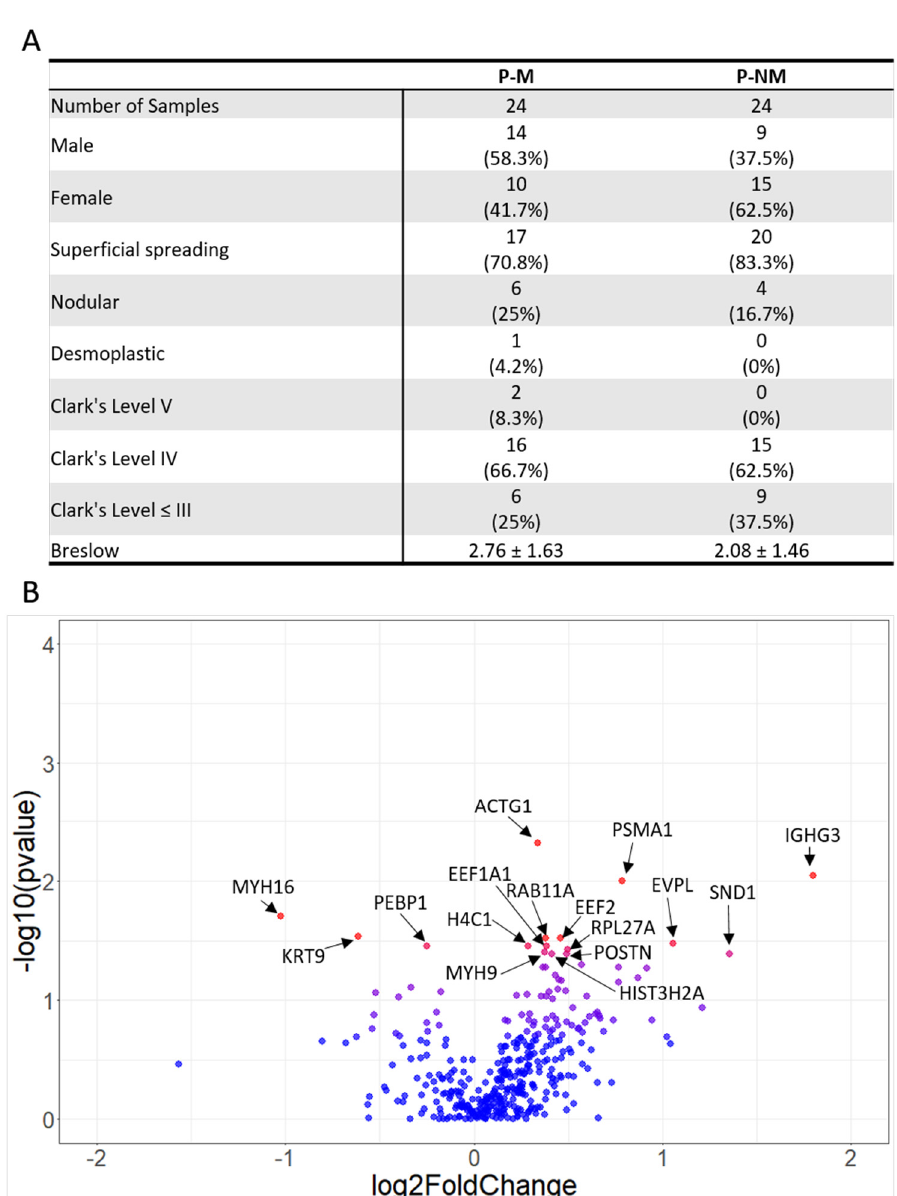
Figure 1. Proteomic analysis of primary melanomas which had metastasised (P-M) and those which had not metastasised (P-NM) reveals 16 significantly differentially expressed proteins. ( A ) clinical characteristics of P-M and P-NM samples. ( B ) Volcano plot of proteomic data. Pvalues were obtained by Mann–Whitney U test and fold changes by dividing the mean of each P-M protein by the mean of the P-NM protein. Blue = p > 0.05, red = p < 0.05.